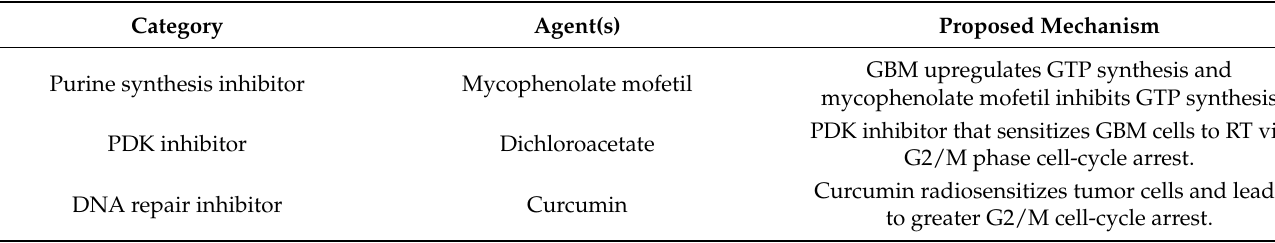
Table 1. Potential avenues for glioblastoma (GBM)